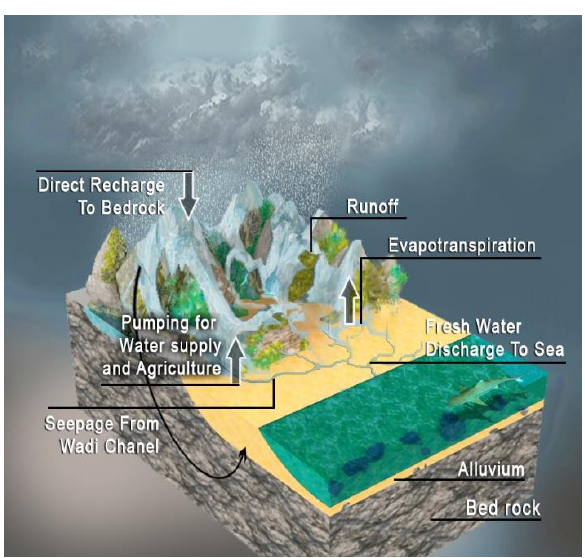
Figure 3. Conceptual model of Wadi Al Jizi groundwater flow system .